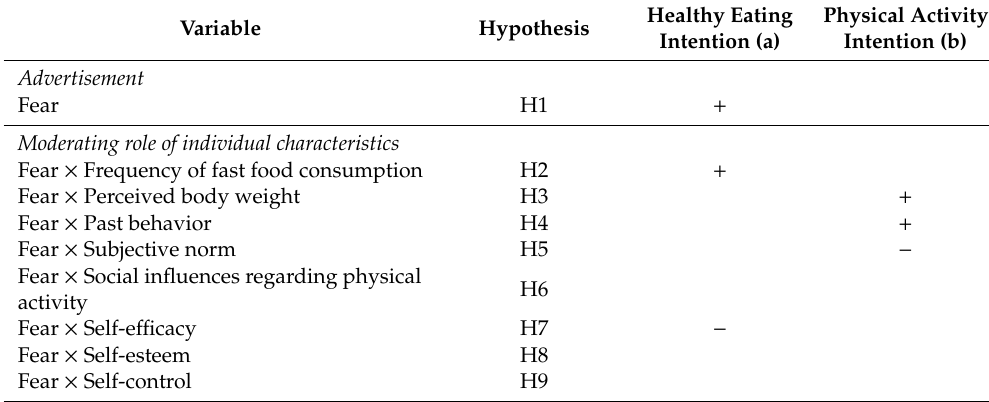
Table 5. Summary of the study’s